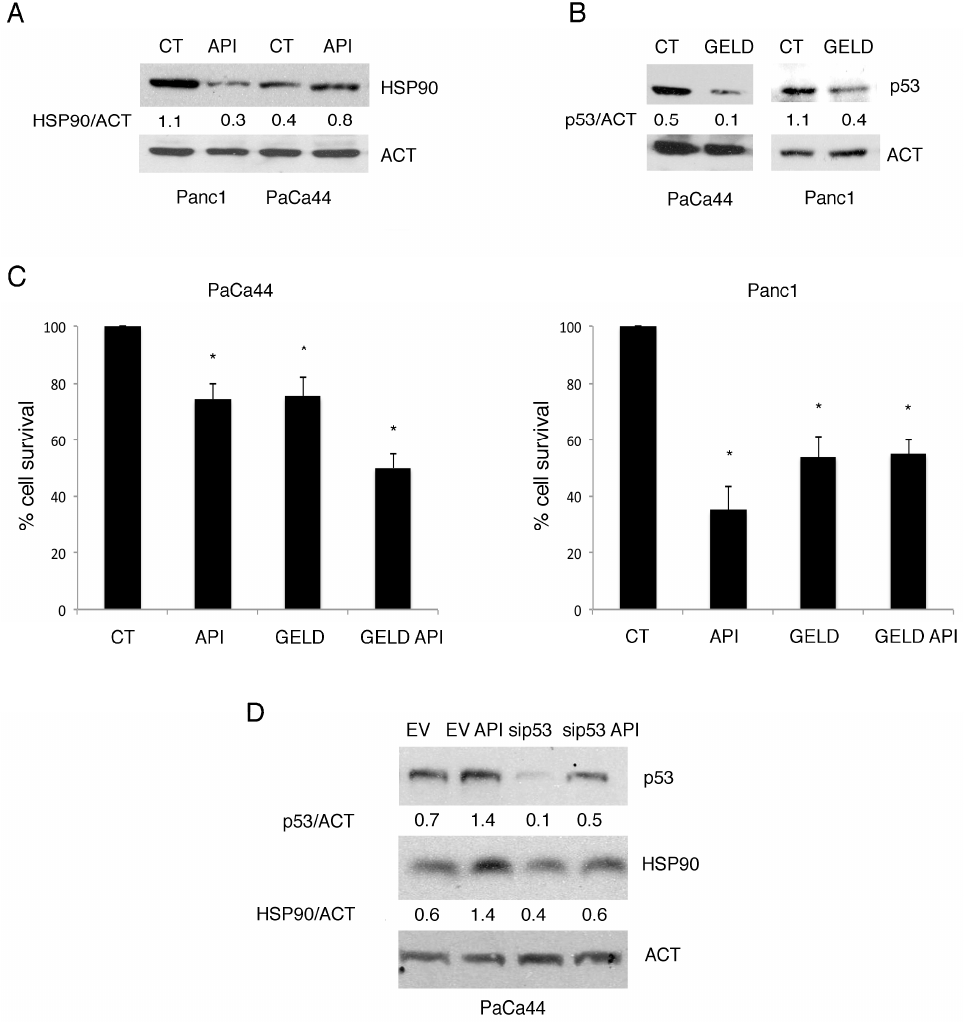
Figure 6. HSP90 induction by Apigenin promotes mutant p53 stability and vice versa. ( A ) HSP90 expression in Apigenin-treated or untreated Panc1 and PaCa44 cells evaluated by western blot analysis. Actin was used as loading control. A representative experiment out of three is shown and the densitometric analysis of the ratio of HSP90 / actin is reported; ( B ) mutp53 expression in 100 nM Geldanamycin (GELD)-treated or untreated PaCa44 and Panc1 cells evaluated by western blot analysis. Actin was used as loading control. A representative experiment out of three is shown and the densitometric analysis of the ratio of Geldanamycin / actin is reported; ( C ) Viability of untreated or 12.5 µ M Apigenin-, 100 nM Geldanamycin-treated, and the combination of 100 nM Geldanamycin and 12.5 µ M Apigenin in PaCa44 and Panc1 cells was evaluated by trypan blue exclusion assay. Mean plus SD of three independent experiments is reported. * p -value < 0.05; ( D ) mutp53 and HSP90 expression in p53- or scramble-silenced PaCa44 cells treated or untreated with 12.5 µ M Apigenin was evaluated by western blot analysis. Actin was used as loading control. A representative experiment out of three is shown and the densitometric analysis of the ratio of p53 / actin and HSP90 / actin is reported. Control (CT); Apigenin (API); heat shock protein 90 (HSP90); actin (ACT); geldanamycin (GELD); empty vector (EV); p53 siRNA